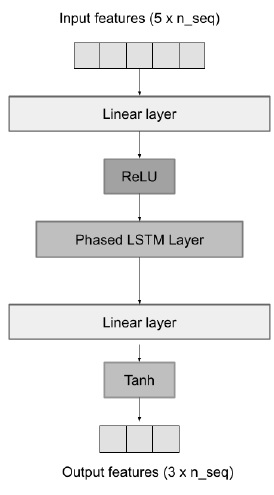
Fig. 3. The stacked LSTM architecture.